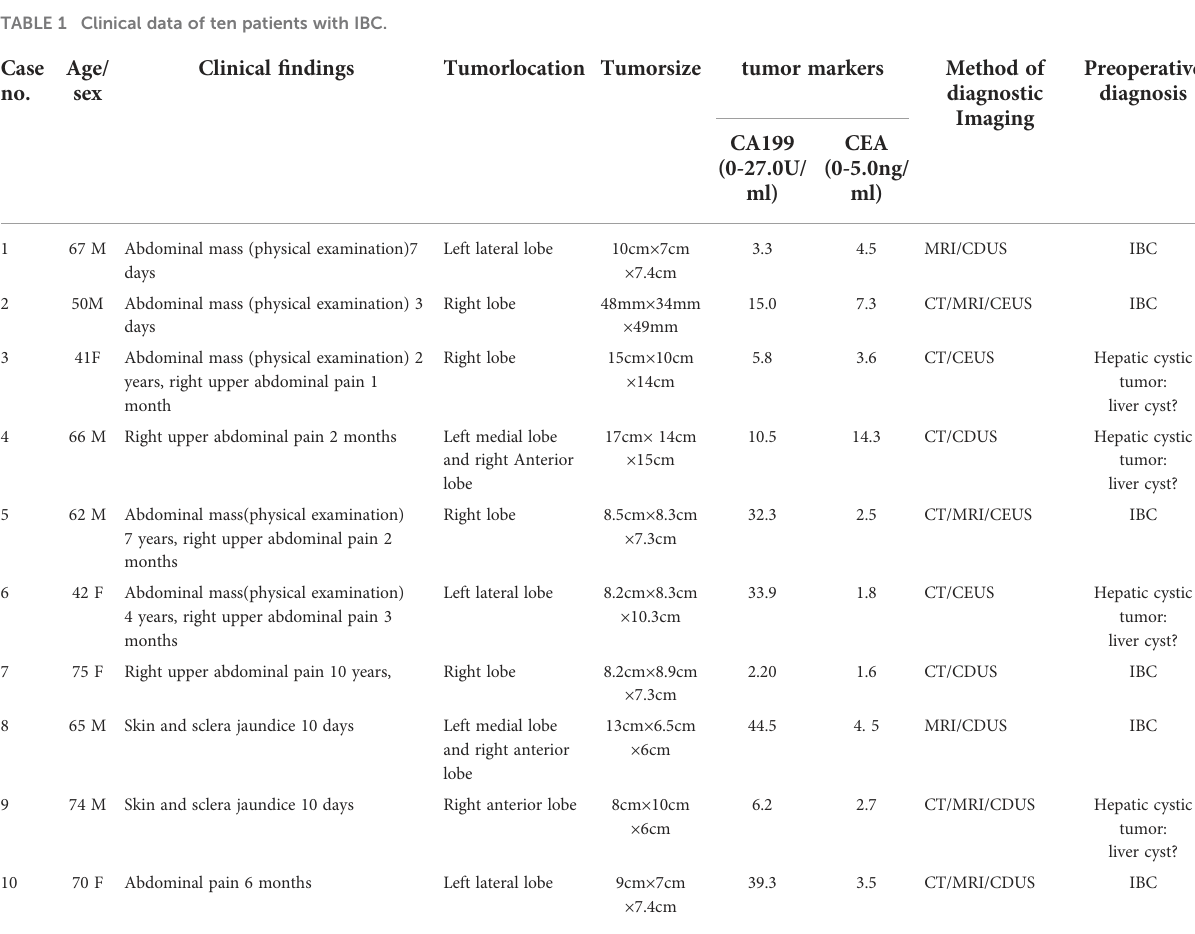
TABLE 1 Clinical data of ten patients with IBC. Case